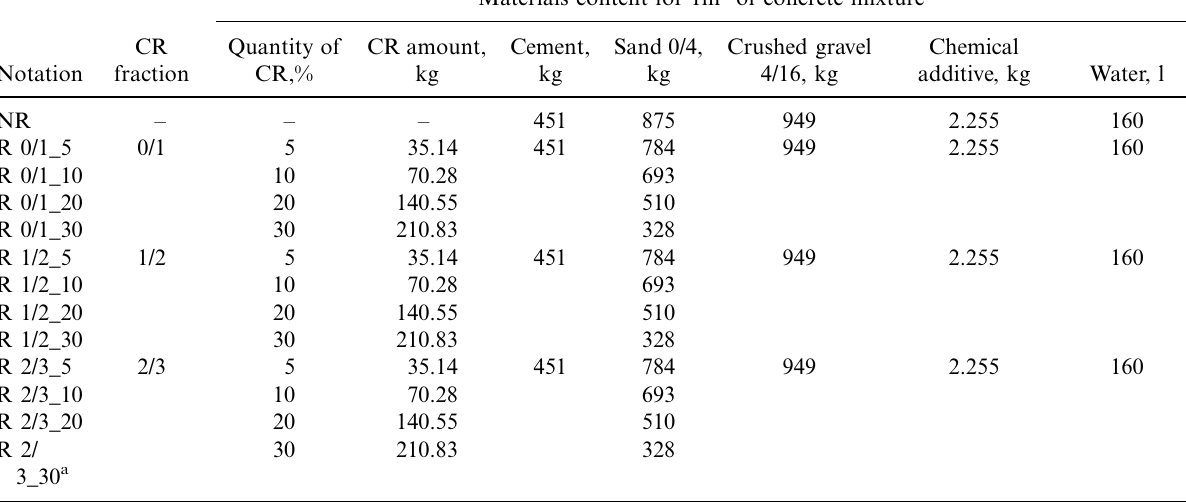
Table 1. Proportions of concrete